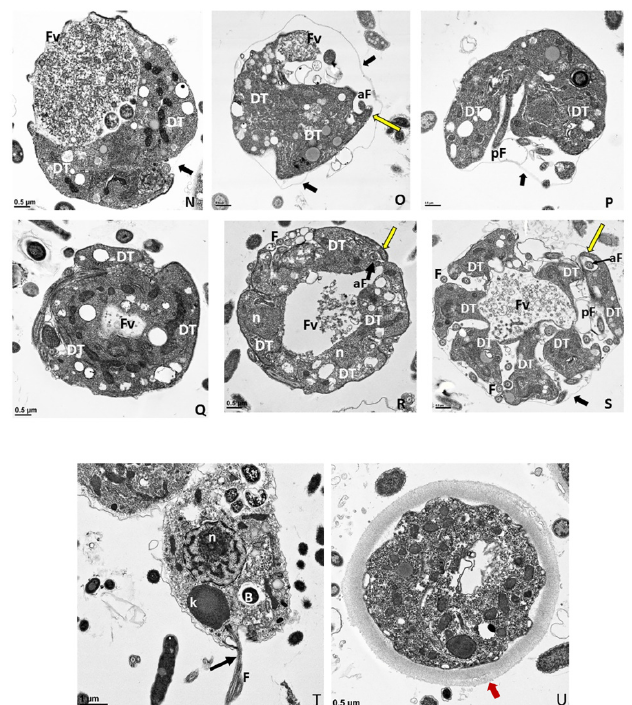
Figure 6. ( A – G ): Transmission electron micrographs of Colpodella sp. (ATCC 50594) life cycle stages. ( A , B ), Trophozoites. ( C ), attachment ( D , enlarged) of Colpodella sp. (ATCC 50594) trophozoite (red arrow) to P. caudatus showing two points of attachment to the plasma membrane of P. caudatus (yellow arrow). Microtubules and organelles are shown at the point of attachment. ( E ), (enlarged F ) microtubules spread out at point of attachment. ( G ), opening shown with cytoplasmic contents of prey aspirated into Colpodella sp. (ATCC 50594) predator. Open arrows show direction of flow of cytoplasmic contents. Bacteria ( B ) in prey were identified. Blue arrows shown points of attachment in predator-prey pairs undergoing myzocytosis. Anterior flagella (aF), developing trophozoite (DT), flagella (F), food vacuole (Fv), nucleus (n), pseudo-conoid (PC), posterior flagella (pF). Scale bars, ( A ) (2 µ m), ( B ) (1 µ m), ( C ) (2 µ m), ( D ) (500 nm), ( E ) (1 µ m), ( F ) (500 nm), and ( G ) (1 µ m). ( H – M ): Transmission electron micrographs of Colpodella sp. (ATCC 50594) life cycle stages. ( H ) (enlarged in I ) shows attachment of Colpodella sp. (ATCC 50594) trophozoites (yellow arrow) to P. caudatus (red arrow) containing rod shaped bacteria in the cytoplasm. Blue arrow shows point of attachment between predator and prey. The plasma membrane of Colpodella sp. (ATCC 50594) is seen surrounding the plasma membrane of P. caudatus (three small black arrows) being pulled into the cytoplasm of Colpodella sp. (ATCC 50594). Open white arrows show the direction of flow of the cytoplasmic contents from the prey. ( J ), (enlarged in K ) shows the posterior food vacuole of Colpodella sp. (ATCC 50594) enlarged after feeding accompanied by disintegration of the anterior end with loss of flagella and apical organelles. ( L ), young cyst of Colpodella sp. (ATCC 50594) with developing trophozoite (DT) and remnant food vacuole. M, young cyst with developing trophozoite and remnant food vacuole. Anterior flagella (aF), developing trophozoite (DT), flagella (F), food vacuole (Fv), mitochondria (m), nucleus (n), pseudo-conoid (PC), posterior flagella (pF). Scale bars, (H) (2 µ m), ( I ) (200 nm), ( J ) (2 µ m), ( K ) (1 µ m), ( L , M ) (0.5 µ m). ( N – S ): Transmission electron micrographs of Colpodella sp. (ATCC 50594) life cycle stages. N-P, shows Colpodella sp. (ATCC 50594) mature cysts containing two developing trophozoites with remnant food vacuoles ( N , O ), black arrows identify the thin cyst wall and the developing pseudo-conoid (yellow arrow) was identified in a developing trophozoite. ( Q – S ) show different number of developing trophozoites in cysts of Colpodella sp. (ATCC 50594). ( Q ), cyst with three DT, ( R ), cyst with four DT and ( S ), cyst with seven DT. One trophozoite is more mature than the other six, and contains a developed pseudo-conoid (yellow arrow), in an asymmetric and asynchronous development of the developing trophozoites. Remnant food vacuoles were identified in panels Q-S. Black arrows identify the thin cyst wall of Colpodella sp. (ATCC 50594) cysts. Anterior flagella (aF), developing trophozoite (DT), flagella (F), food vacuole (Fv), mitochondria (m), nucleus (n), pseudo-conoid (PC), posterior flagella (pF). Scale bars, N to S (0.5 µ m). ( T – U ): ( T ), Trophozoite of P. caudatus showing the nucleus (n), kinetoplast (k), flagella (F) and black arrow is paraflagellar rod. ( U ), Cyst of P. caudatus showing the thick cyst wall (red arrowhead). Bacteria (B) were identified in the cytoplasm of P. caudatus. Scale bars, ( T ) (1 µ m) and ( U ) (0.5 µ